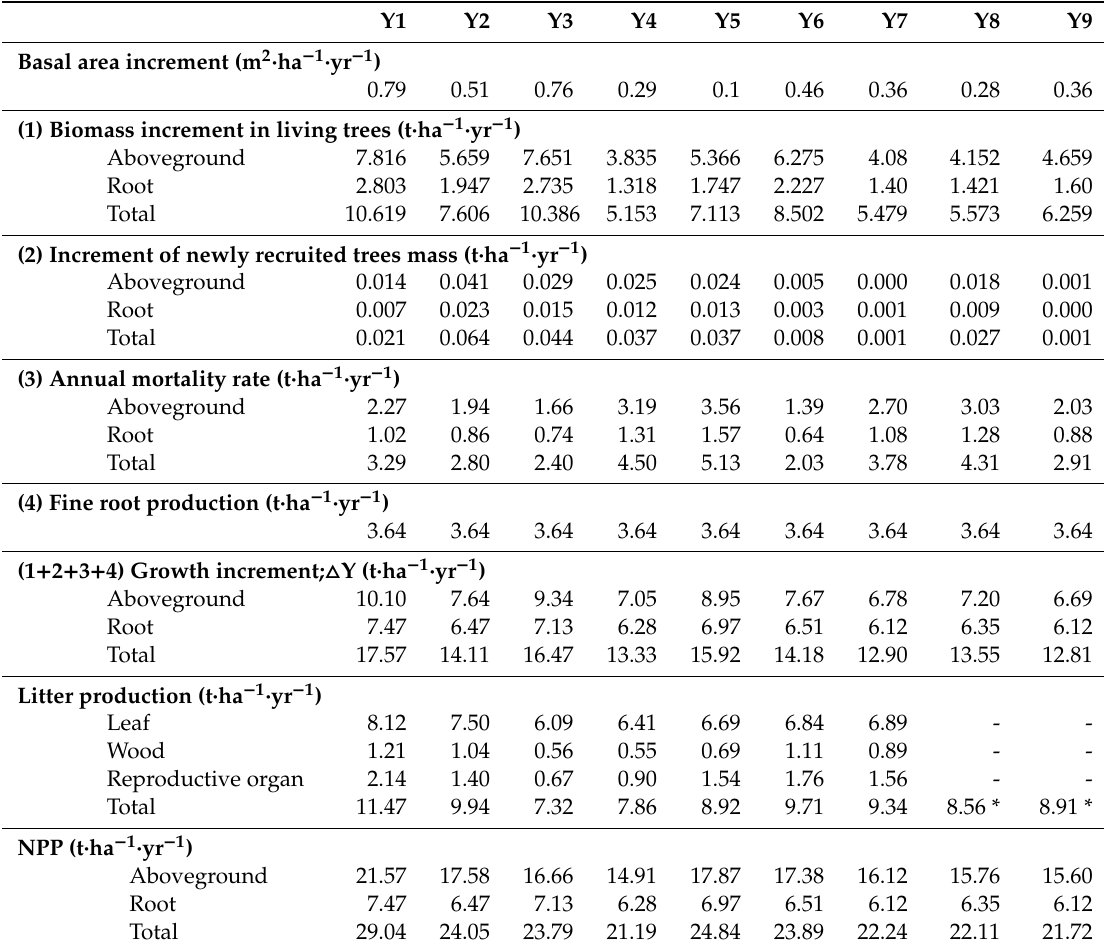
Table 1. Basal area increment, growth increment ( ∆ Y), litter production (L), and NPP in the permanent plot at a secondary mangrove forest in Trat from Y1 to Y9. Y1 Y2 Y3 Y4 Y5 Y6 Y7